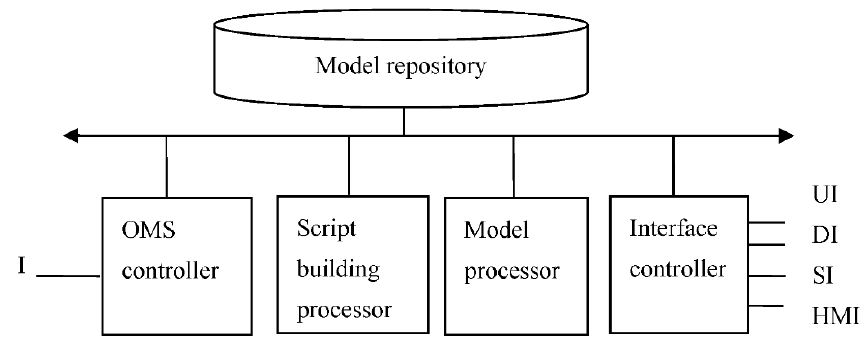
Figure 3. DDT reference structure.